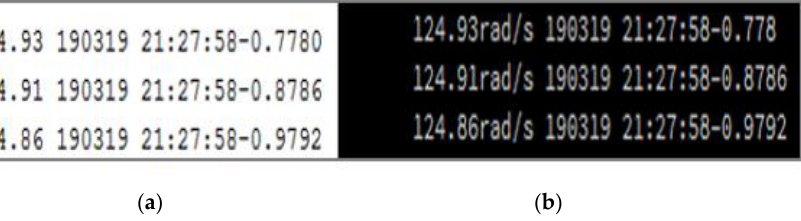
Figure 7. The GPS module, CPU Arduino Uno, and Shield Ethernet.